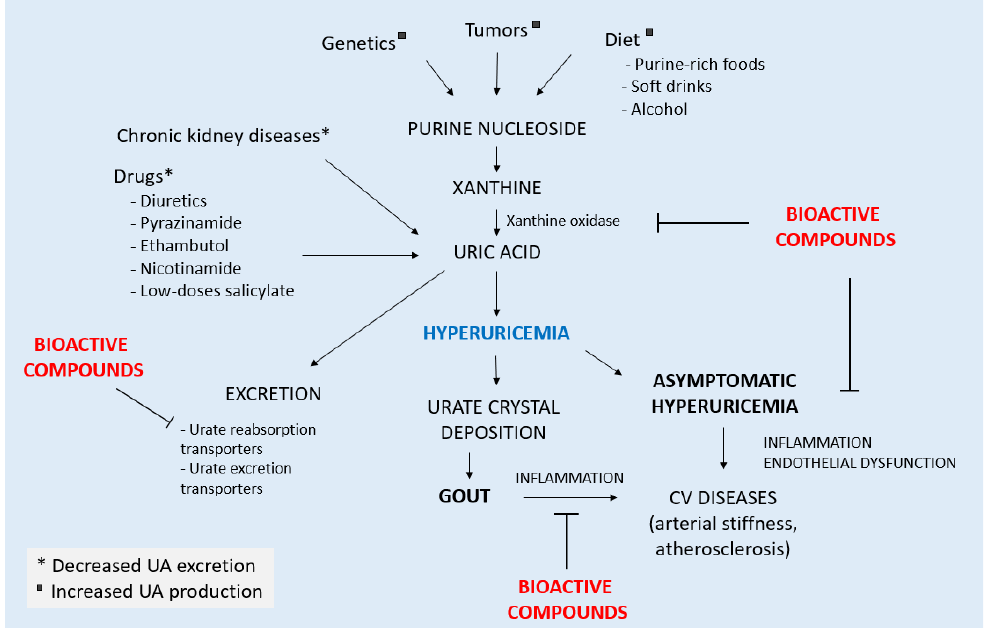
Figure 1. Conditions leading to hyperuricemia and gout in humans.